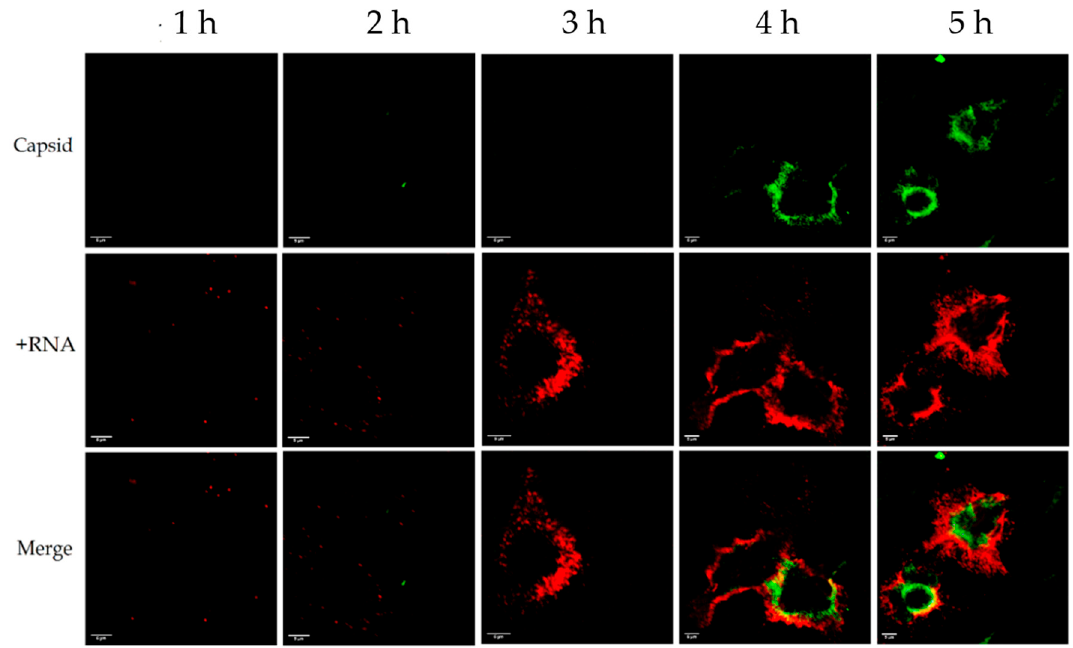
Figure 1. Distribution of viral + RNA and capsid protein in coxsackievirus A9 (CVA9)-infected cells 1–5 h post-infection (p.i.). The capsid protein is shown in green and the + RNA is shown in red. The rows from left to right are 1, 2, 3, 4, and 5 h p.i. Capsid protein became visible after 4 h p.i. and + RNA was visible at all timepoints, but surged in visibility at 3 h p.i. Around 30% of the capsid colocalized with the + RNA. Scale bar in every image is 5 µ